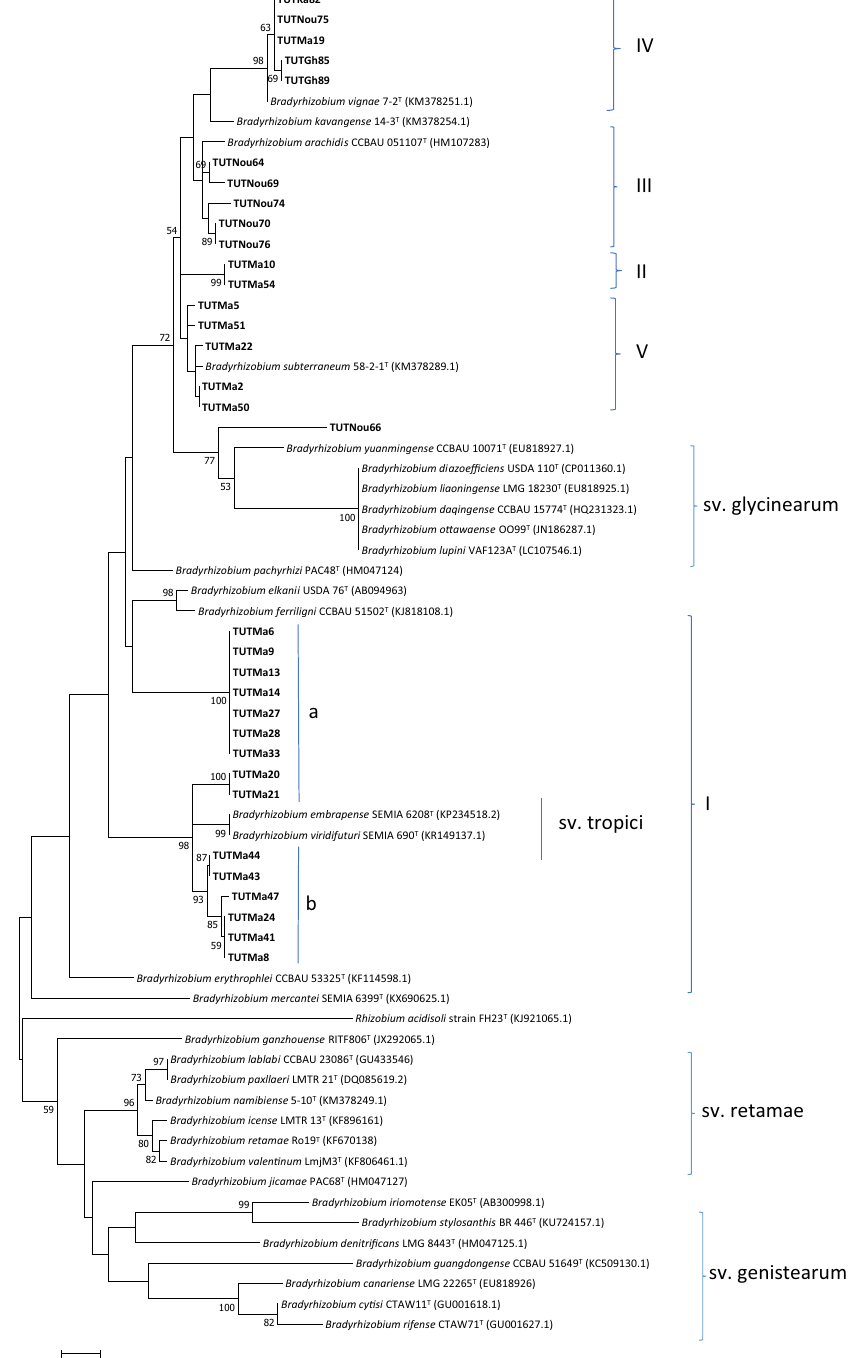
Figure 5. Phylogenetic tree based on nifH gene sequences generated by Maximum likelihood method. Bootstrap values (1000 replicates) are indicated above the branches which shows the percentage of trees in which the associated taxa clustered together. The number of nucleotide substitution is indicated by scale bar. All missing and gap nucleotide sequences were eliminated during phylogenetic tree construction. Evolutionary analyses were conducted in